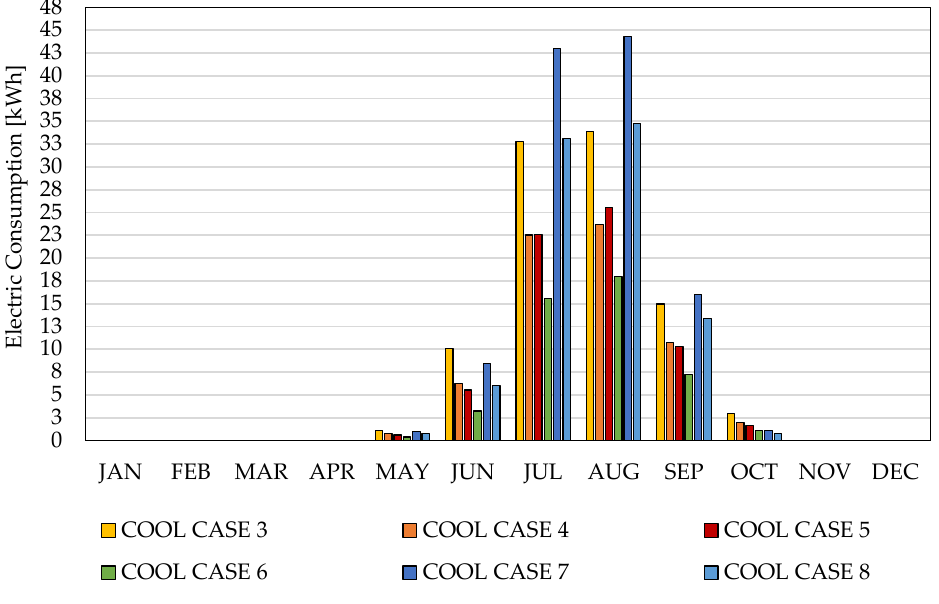
ing mode. A double layer significantly reduces the electricity consumption every month,